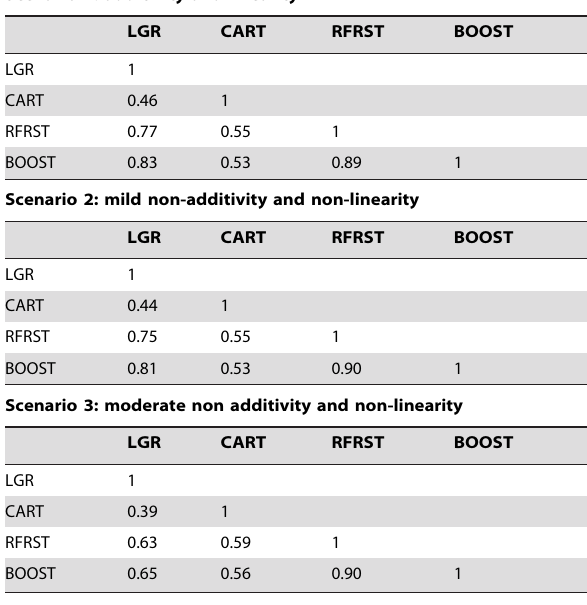
LGR: logistic regression. CART: classification and regression trees. RFRST: random forests. BOOST: boosted